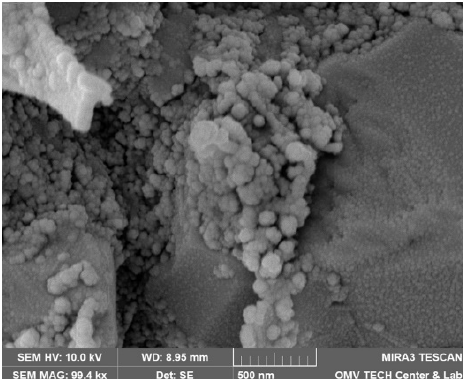
Figure 15. Scanning electron microscopy (SEM) image of a core flood rock sample following an injection of 1 wt% nanofluid A in test water.